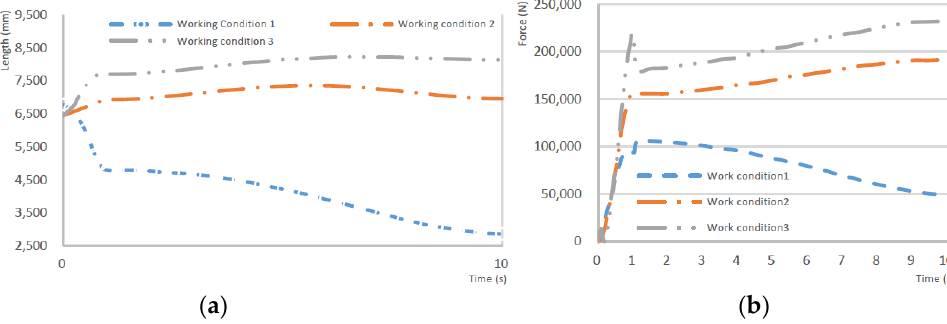
Figure 5. Simulation of the main cylinder under three typical work conditions: ( a ) The end of the main cylinder trajectory; ( b ) Main cylinder force.